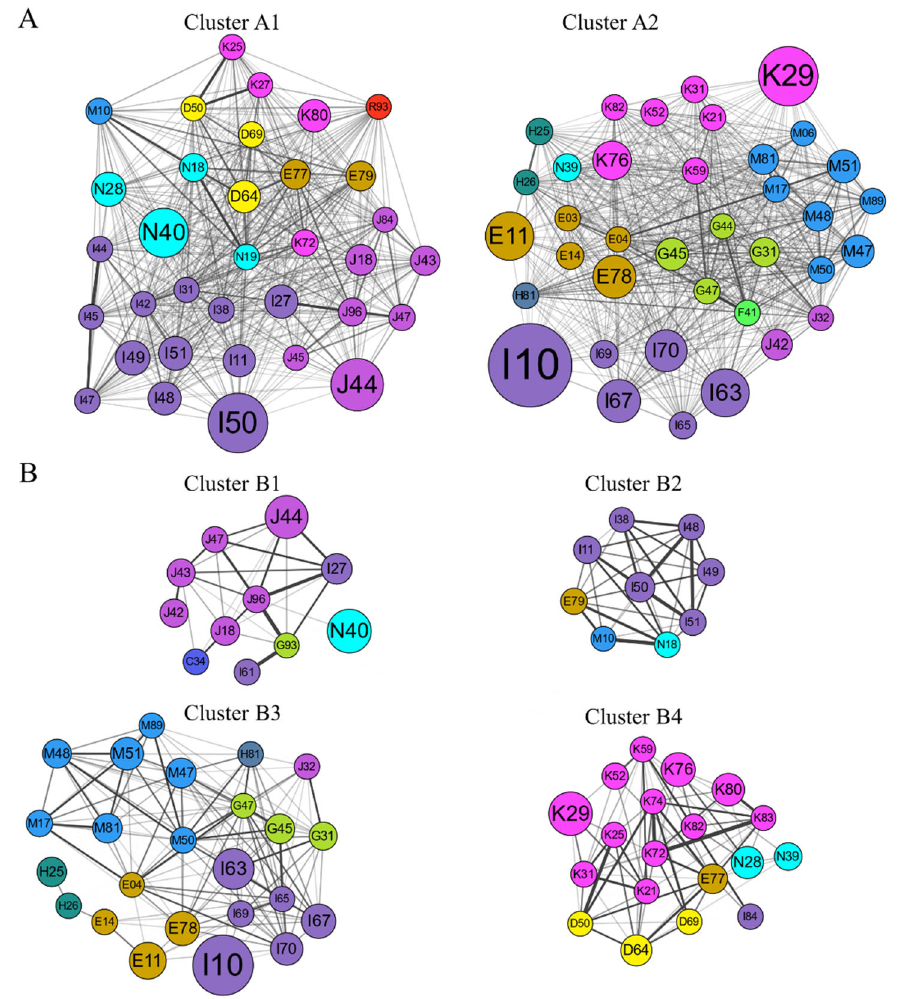
Figure 4. Clustering of comorbidity networks in patients with IHD ( A ) and controls ( B ). Nodes represent comorbidities and colored with disease chapters, node size indicates prevalence, and edge thickness represents observed ‐ to ‐ expected ratio (OER).